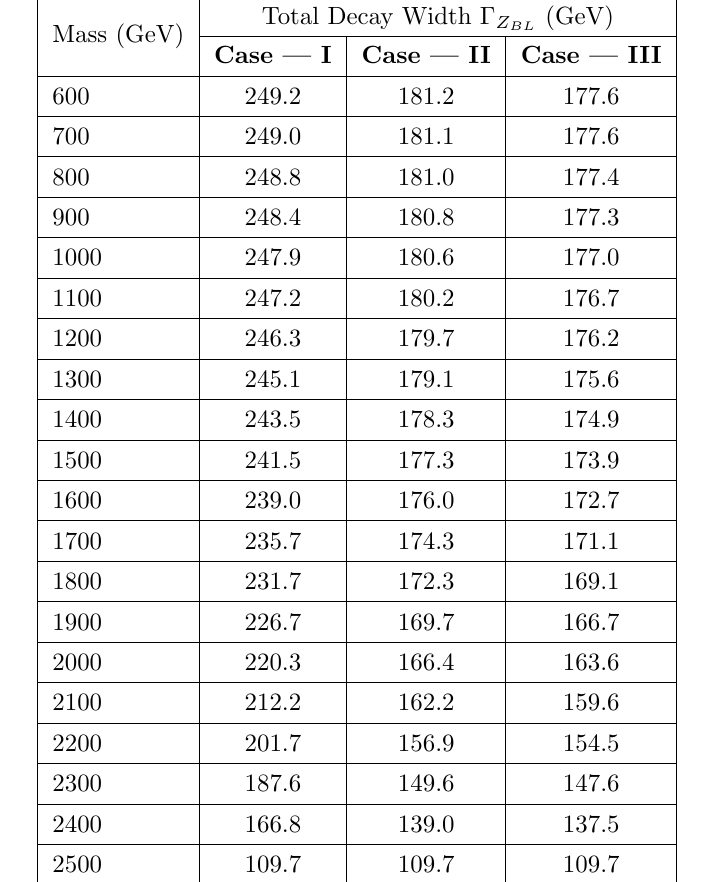
Figure 11 . Left panel: plot showing improvement in production cross-section of the (cid:6) to Z BL mediation for two choices of centre of mass energies in proton proton collisions. Right panel: decay length of (cid:6) versus its mass compared with the ATLAS bound on disappearing charge track 3 searches at 13 TeV centre of mass energy.